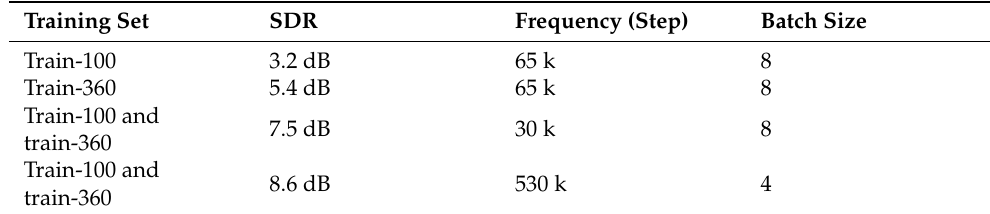
Table 3. Evaluation of speaker separation